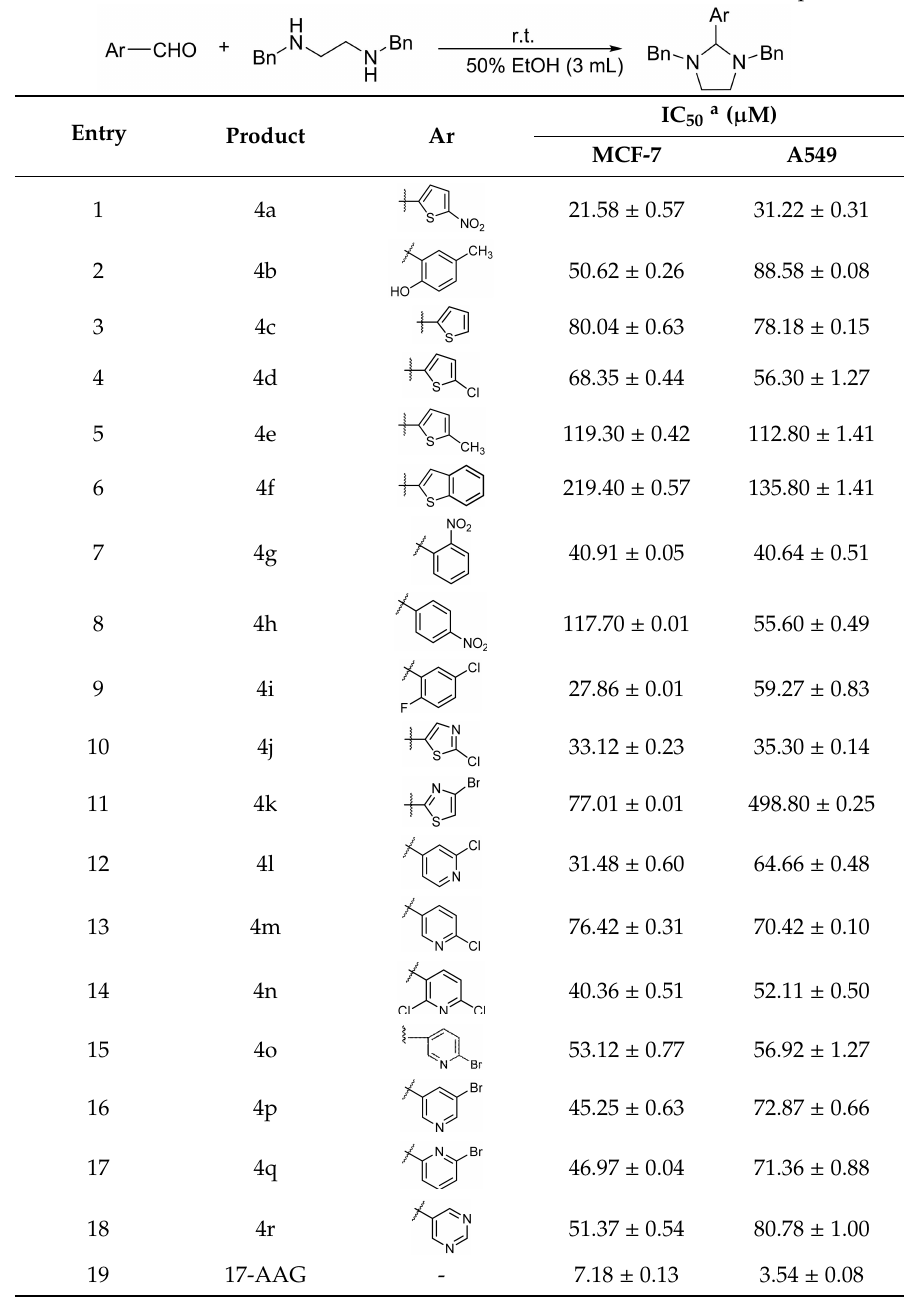
Table 1. Structure of 4a – 4r and their IC 50 values ( µ M) on MCF-7 and A549 cell lines, 48-h post